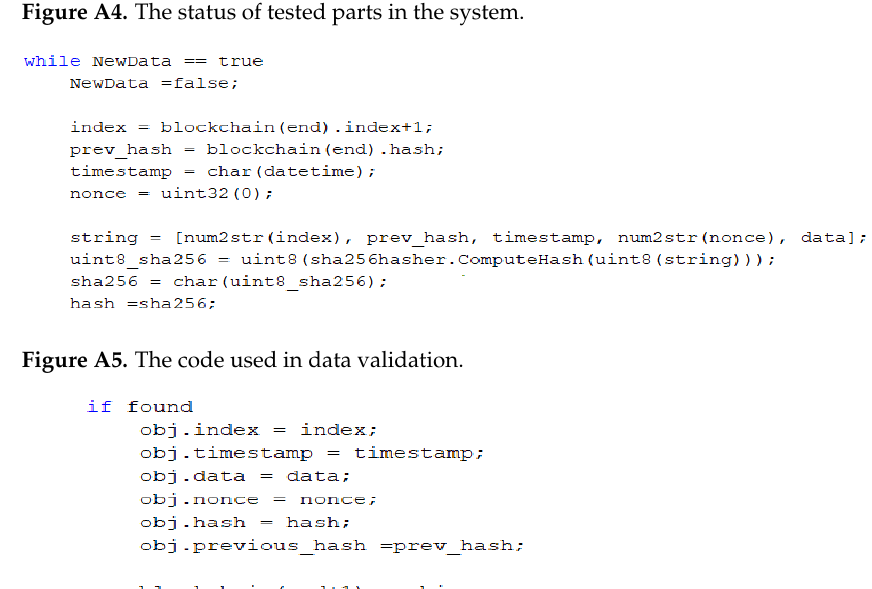
Figure A4. The status of tested parts in the system.